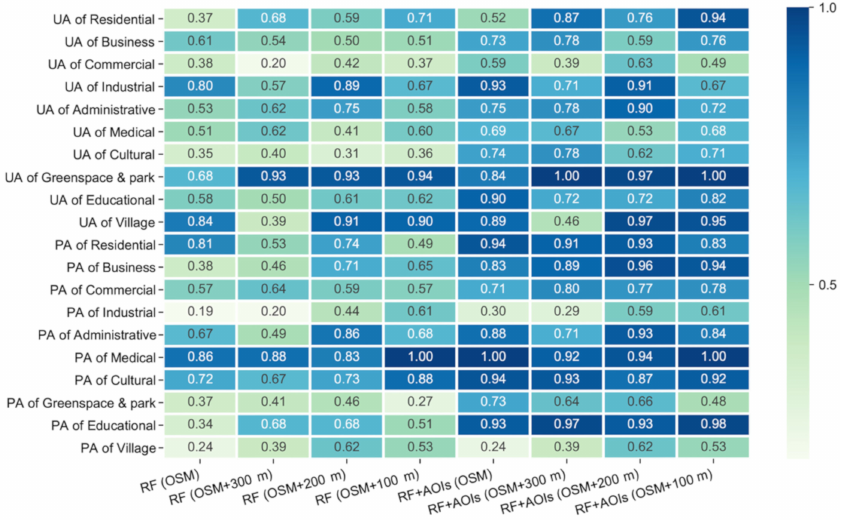
Figure 14. Accuracy assessment of mapping results of EULUC-AOI in Beijing, 2019. UA and PA donate user’s accuracy and the producer’s accuracy,